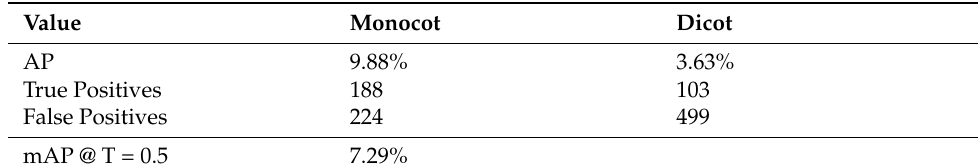
Table 3. Network training results for Training Image Set